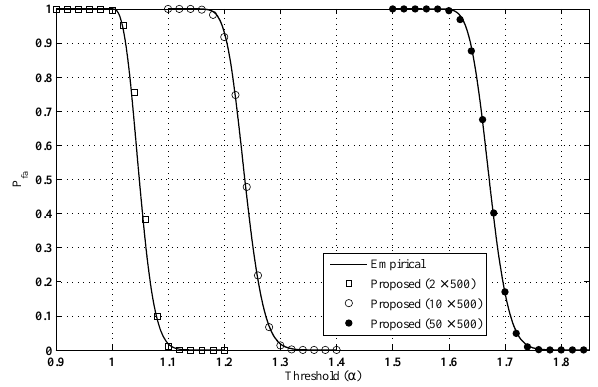
Figure 1. Empirical and Analytical mean of SLE ( µ correlation coefficient between largest eigenvalue and trace ( ρ ) under H hypothesis for different values of K where N = 500 1 sample and r = − 10 dB .